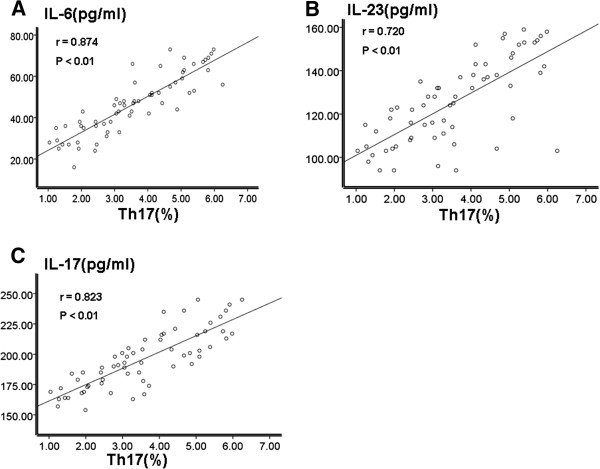
Correlation analysis of levels of Th17 cells and levels of IL-6, IL-23 and IL-17 in the UCC group. Correlation assay was conducted using the Spearman rank correlation test. (A) Correlation analysis between Th17 and IL-6; (B) Correlation analysis between Th17 and IL-23; (C) Correlation analysis between Th17 and IL-17.